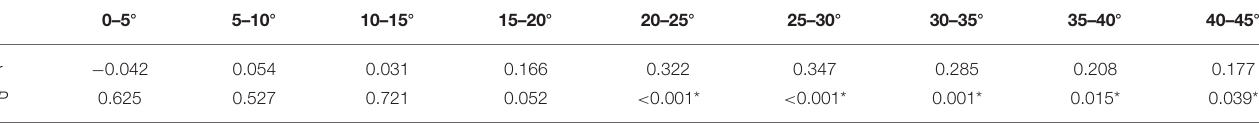
TABLE 2 | Correlation between relative peripheral refractive errors (RPRE) and axial length (AL) at different eccentricities.